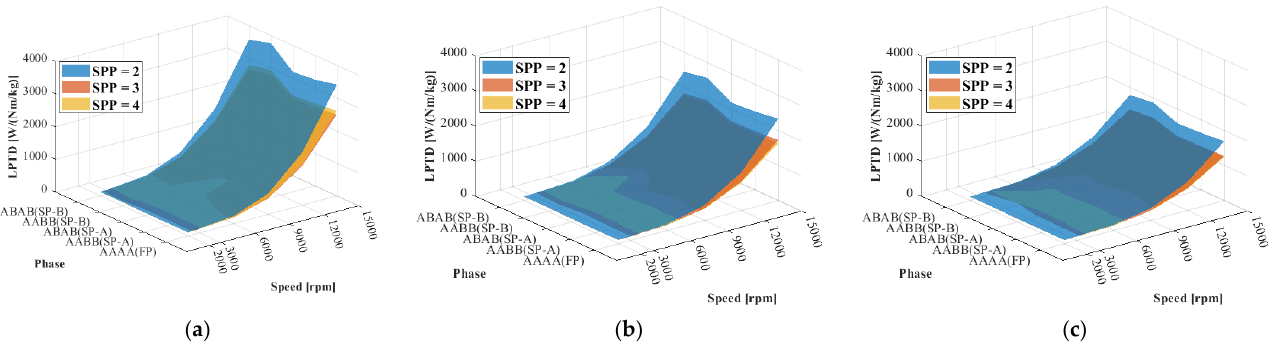
Figure 17. Comparison of LPTD under 20% of peak torque condition as a function of phase arrangement and speed for three SPP values: ( a ) four conductors; ( b ) six conductors; ( c ) eight conductors.